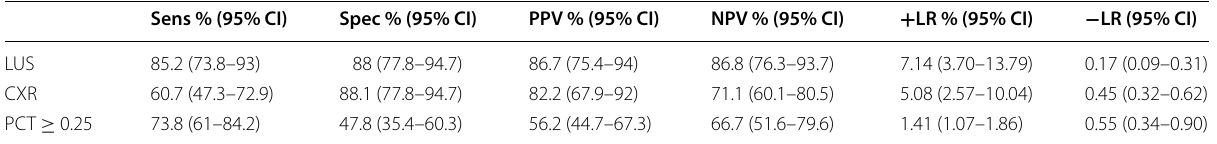
Table 3 Diagnostic performance of lung ultrasonography, chest radiograph and procalcitonin for the diagnosis of pneu- monia